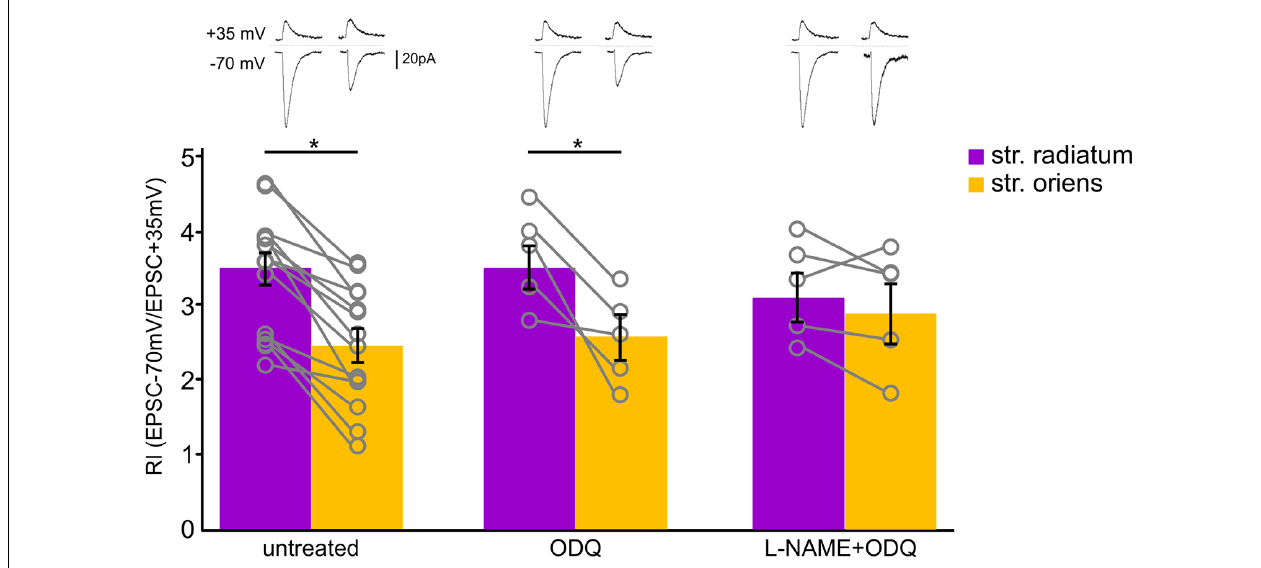
FIGURE 6 | Soluble guanylyl cyclase inhibition did not affect CP-AMPAR contribution to synaptic transmission of CA1 pyramidal cells. Comparison of rectification indices in stratum radiatum (purple) and stratum oriens (orange) in untreated cells ( n = 14 cells from nine animals) and under treatment with ODQ (30 µ M, n = 5 cells from three animals) and L-NAME (200 µ M, n = 5 cells from three animals). Top, example traces. * p ≤